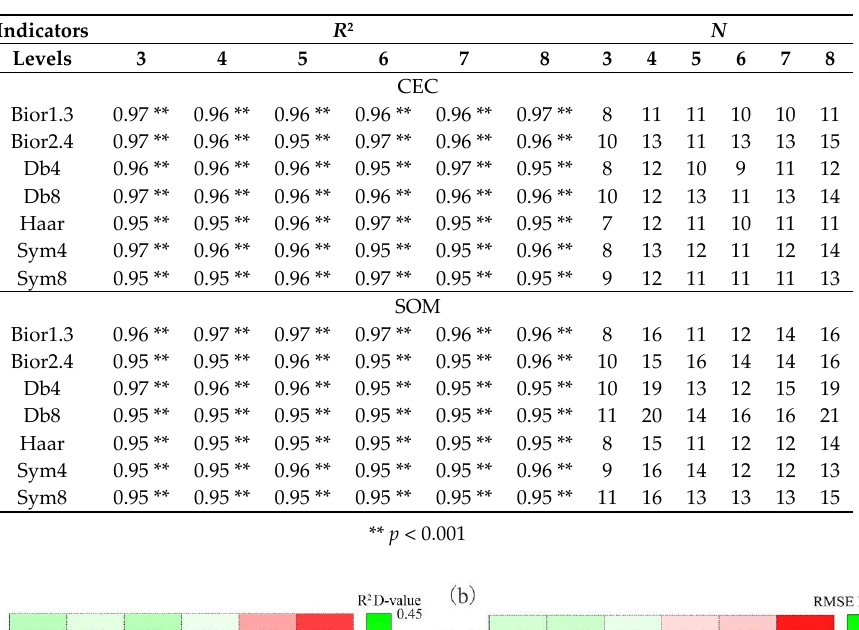
Table 6. Coefficient of determination ( R 2 ) and number of variables ( N ) used in DWT–Stepwise-PLS models for CEC and SOM in the calibration set.